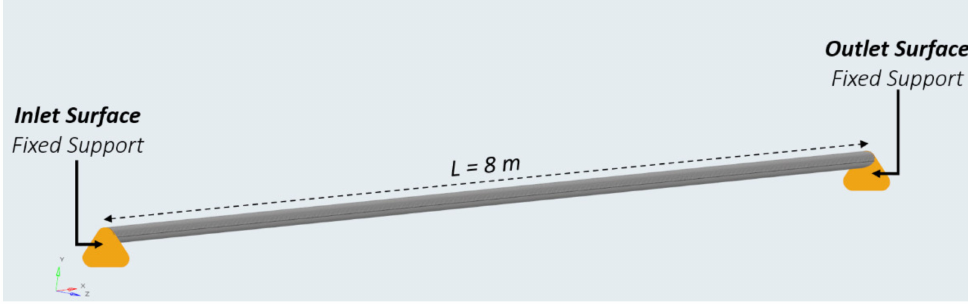
Figure 4. Representation of solid domain in Altair OptiStruct and the applied boundary